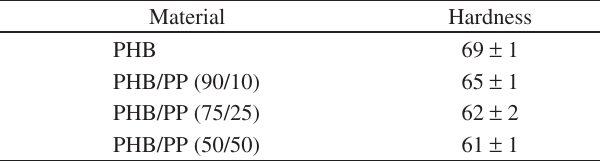
Table 4. Shore D hardness values for PHB and PHB/PP blends.